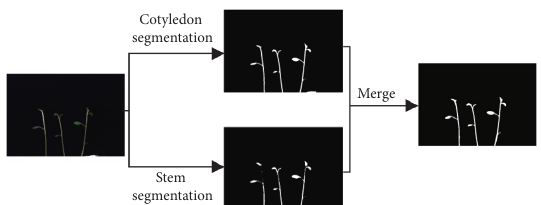
Figure 3: Segmentation process of the potato test-tube